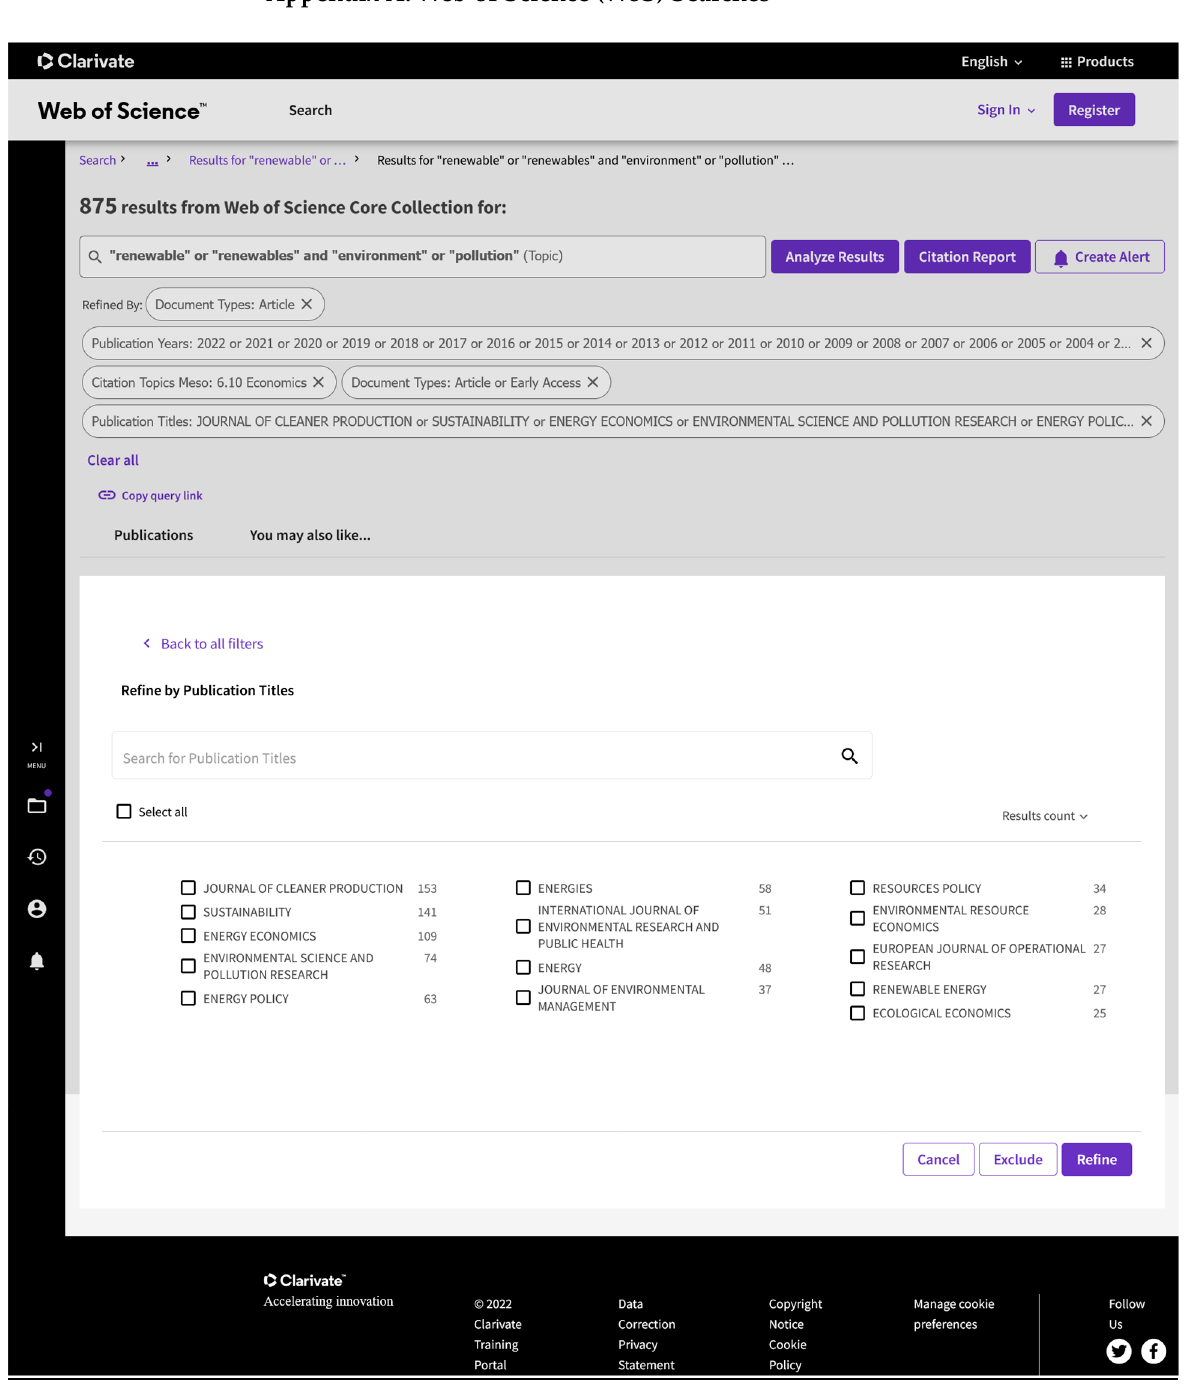
Figure A1. WOS Search—All Journals.